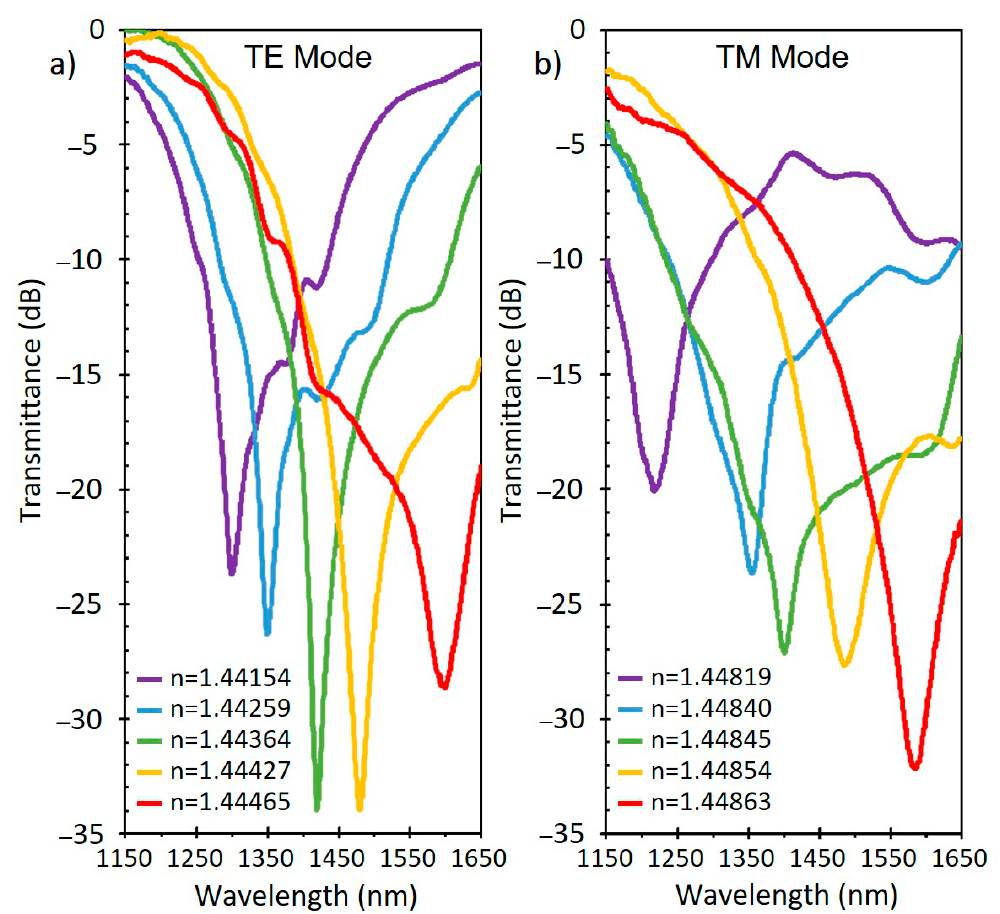
Figure 8. Transmittance of a D-shaped fiber with a tin oxide thin film with different SRI. Shown is the LMR corresponding to the TE mode ( a ) and TM mode ( b ). Reprinted from [32].